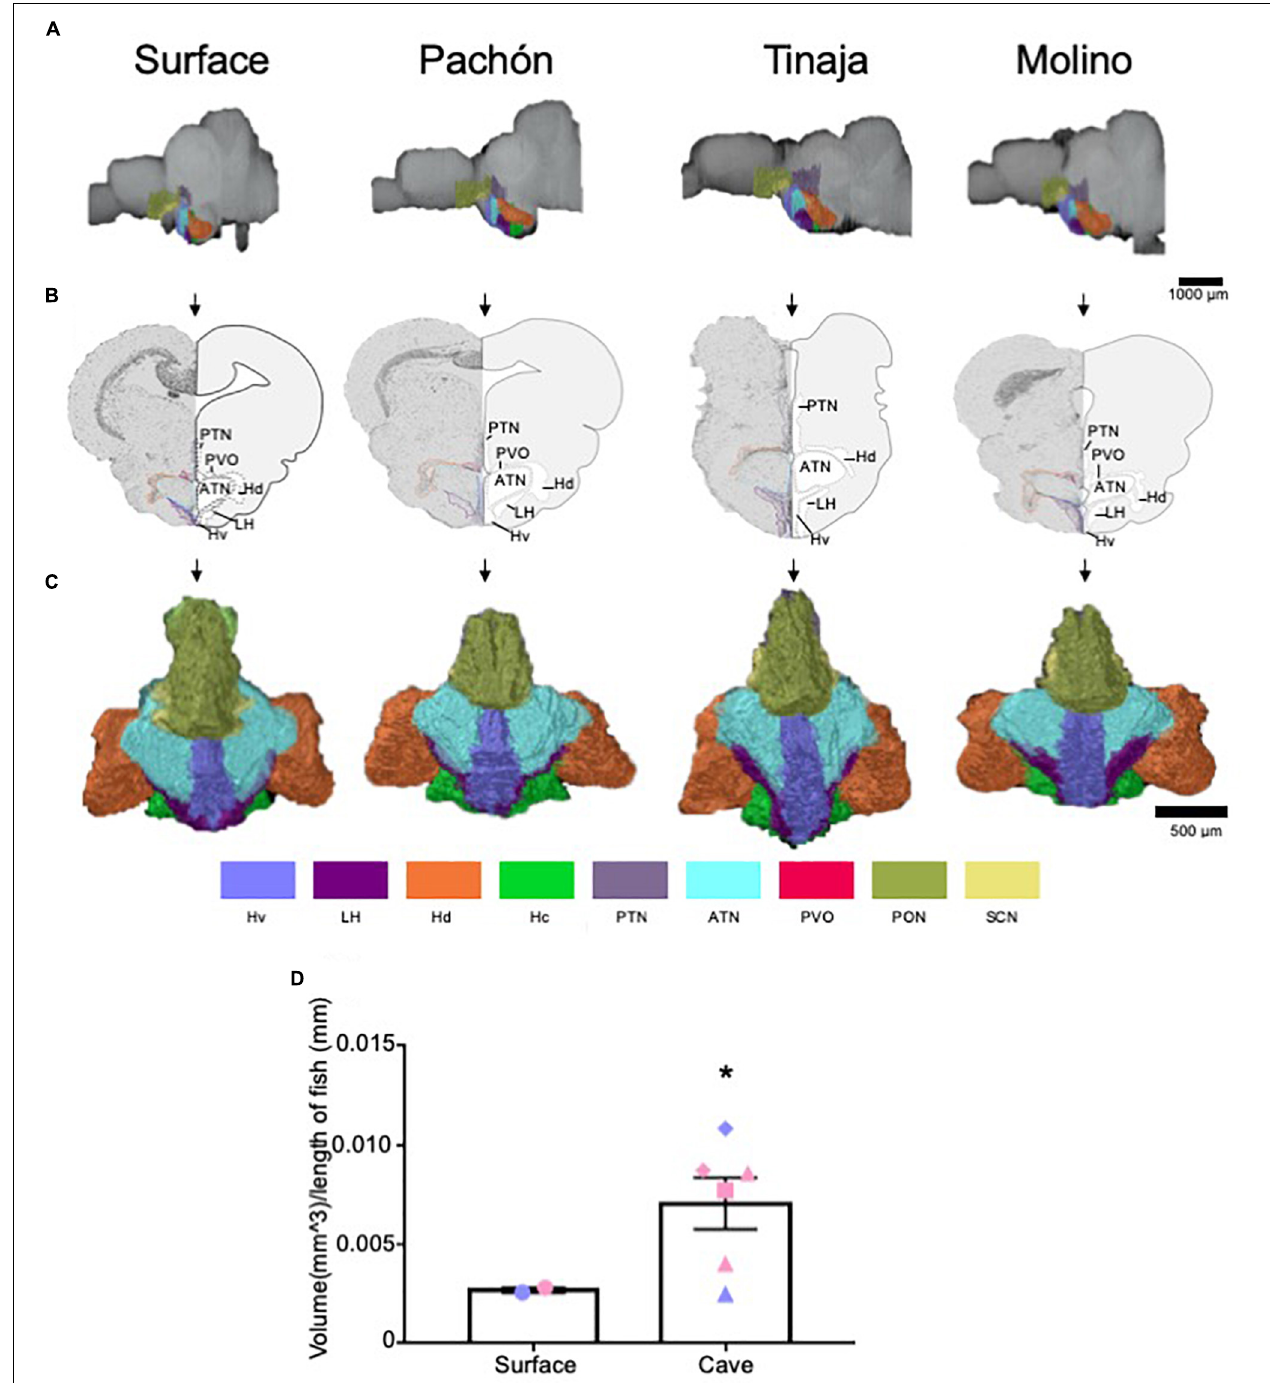
FIGURE 5 | Quantification of the hypothalamus reveals expansion in cave populations. (A) 3-D reconstructions of Surface, Pachón, Tinaja and Molino with demarcated hypothalamus displayed. (B) Images of demarcated sections that were Nissl stained (left) and a cartoon of demarcated region (right). (C) 3-D reconstruction of the hypothalamus only, displayed from an anterior view. (D) Quantification of the total volume of the hypothalamus revealed expansion in cavefish (surface fish 0.0027 ± 0.0001, cavefish 0.0071 ± 0.0013, t -test t = 1.855, df = 6, p ≤ 0.05). Graph in D is the mean ± standard error of the mean. Color key for subnuclei (Hv = Ventral zone of periventricular hypothalamus, LH = Lateral hypothalamic nucleus, Hd = Dorsal zone of periventricular hypothalamus, Hc = Caudal zone of periventricular hypothalamus, PTN = Posterior tuberculum, ATN = Anterior tuberculum, PVO = Paraventricular organ PON = Preoptic nucleus, SCN = Superchiasmatic nucleus). Blue points on bar graphs denote males, whereas light red denotes female. Square points on graphs represent Pachón, triangle points on graphs represent Tinaja and diamond points on graphs represent Molino.